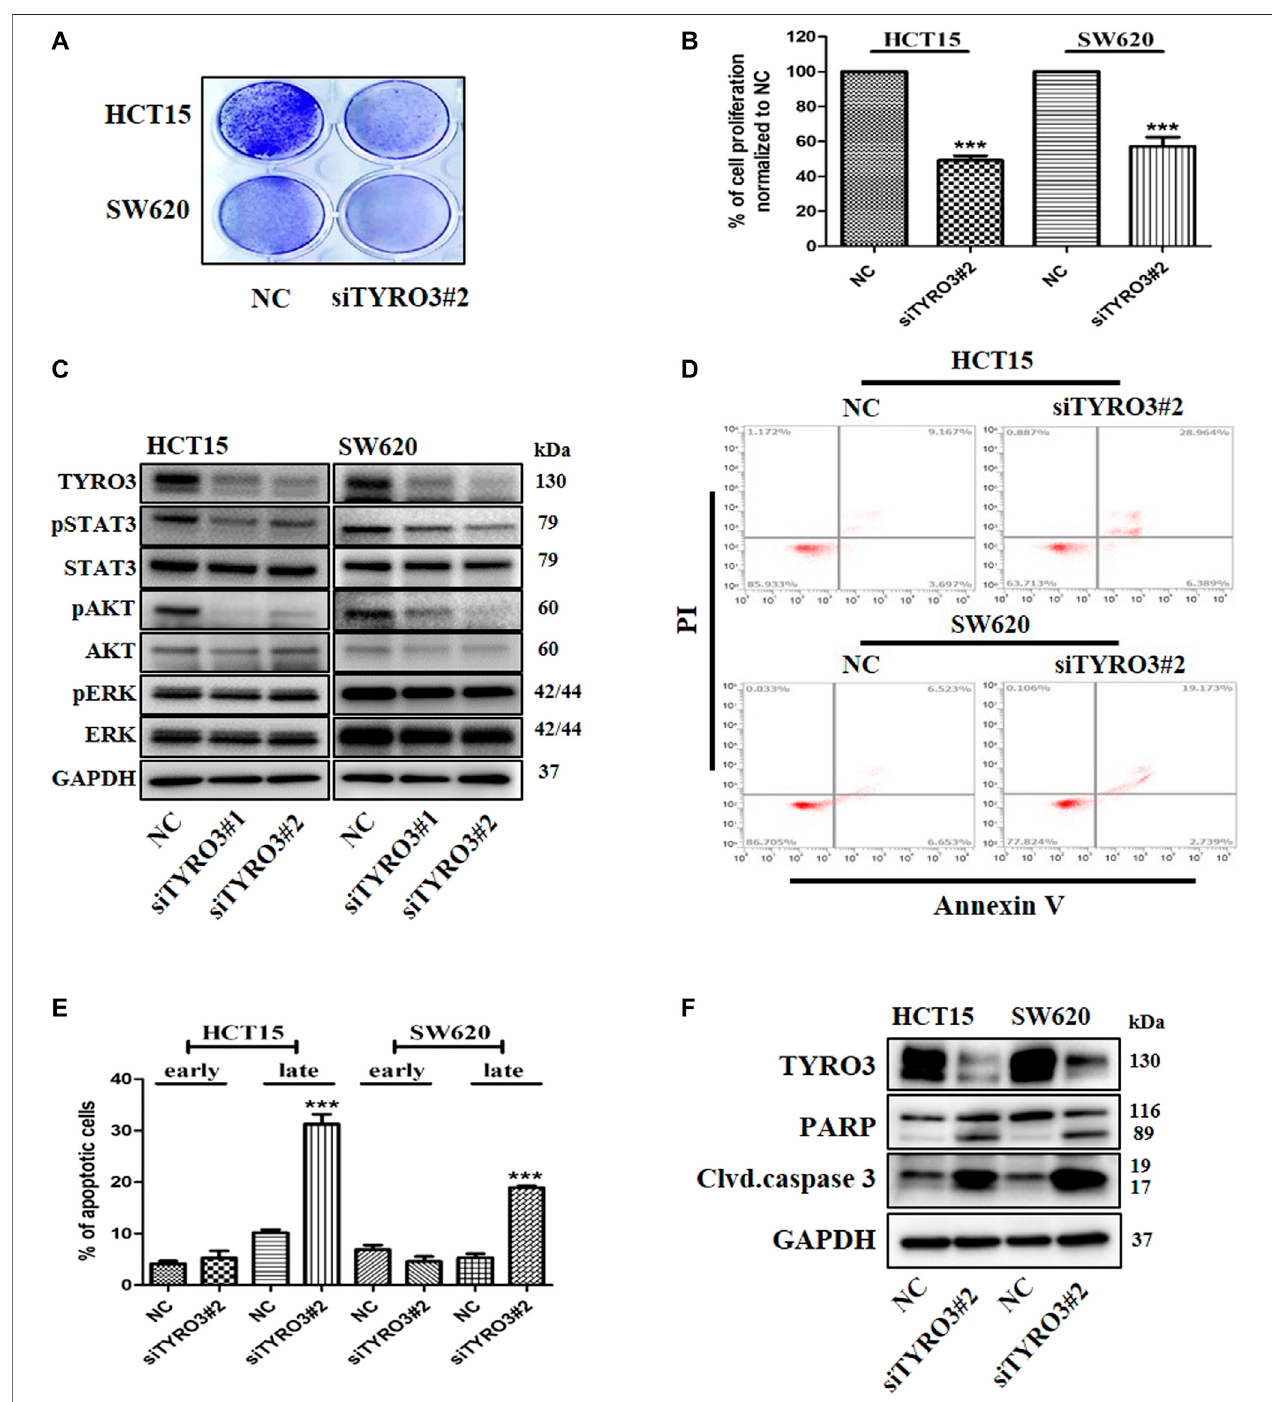
FIGURE2| Knock-downofTYRO3bysiRNAinhibitscellproliferationandinducesapoptosisincoloncancercelllines. (A) CellsweretransfectedwithTYRO3,and negative control (NC) siRNA for 72 h. Cells were stained with 0.5% crystal violet. (B) Cells were incubated for 72 h after transfection with TYRO3, and NC siRNA. The viabilities of the transfected cells were measured using an MTS proliferation assay. (C) HCT15 and SW620 cells were transfected with TYRO3, and NC siRNA for 72 h. Equal amountsofcelllysates werethensubjectedtoelectrophoresisand analyzed viawesternblotusinganti-TYRO3,-phospho-STAT3,-STAT3, -phospho-AKT, -AKT,-phospho-ERK,-ERK,and – GAPDHantibodies. (D,E) HCT15andSW620cellsweretransfectedwithsiRNAfor72 h.Apoptoticcellswerestainedwithpropidium iodide/Annexin V and then analyzed by fl ow cytometry. Early apoptotic cells and late apoptotic cells are displayed as bar graph. (F) Cells were transfected with TYRO3, and NC siRNA for 72 h and then analyzed via western blot using anti-PARP, -cleaved caspase 3 and – GAPDH antibodies. Data are presented as means ± standard deviations (SD). Data were analyzed using one-way ANOVA with Tukey ’ s multiple comparison post-hoc analysis; **** p < 0.0001, *** p < 0.001, ** p < 0.01, * p < 0.05.